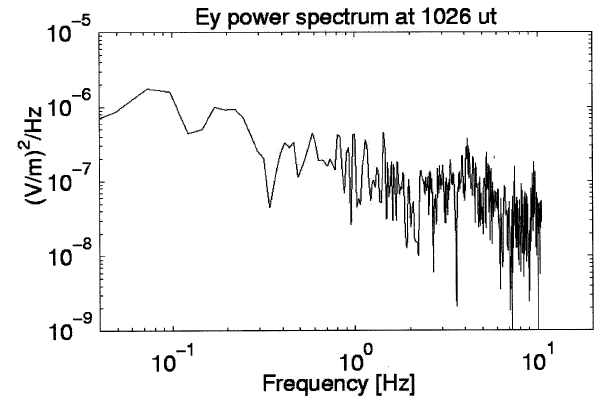
Figure 11. Fig. 11. Electric field power at time 10:26